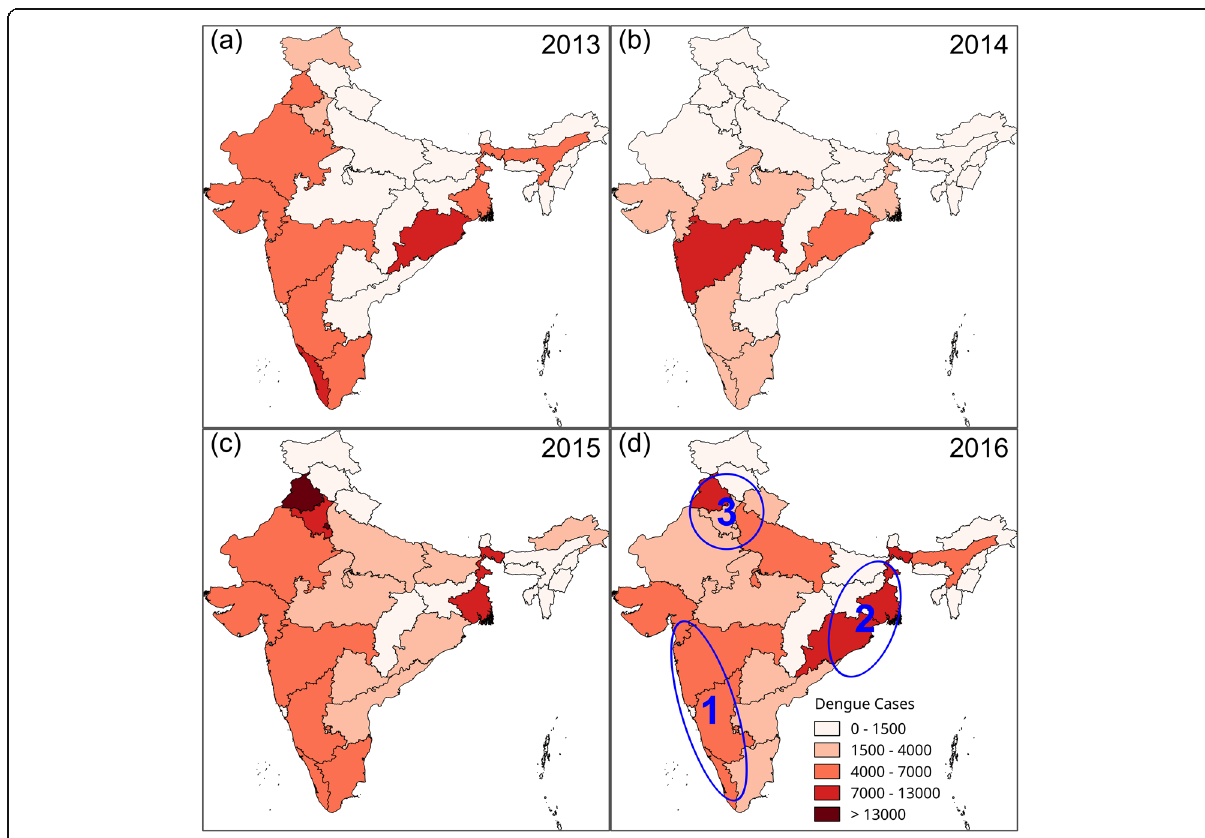
Fig. 3 The shaded maps display state-wise variations in annual dengue cases from 2013 to 2016. Three areas consistently impacted by dengue fever are outlined in